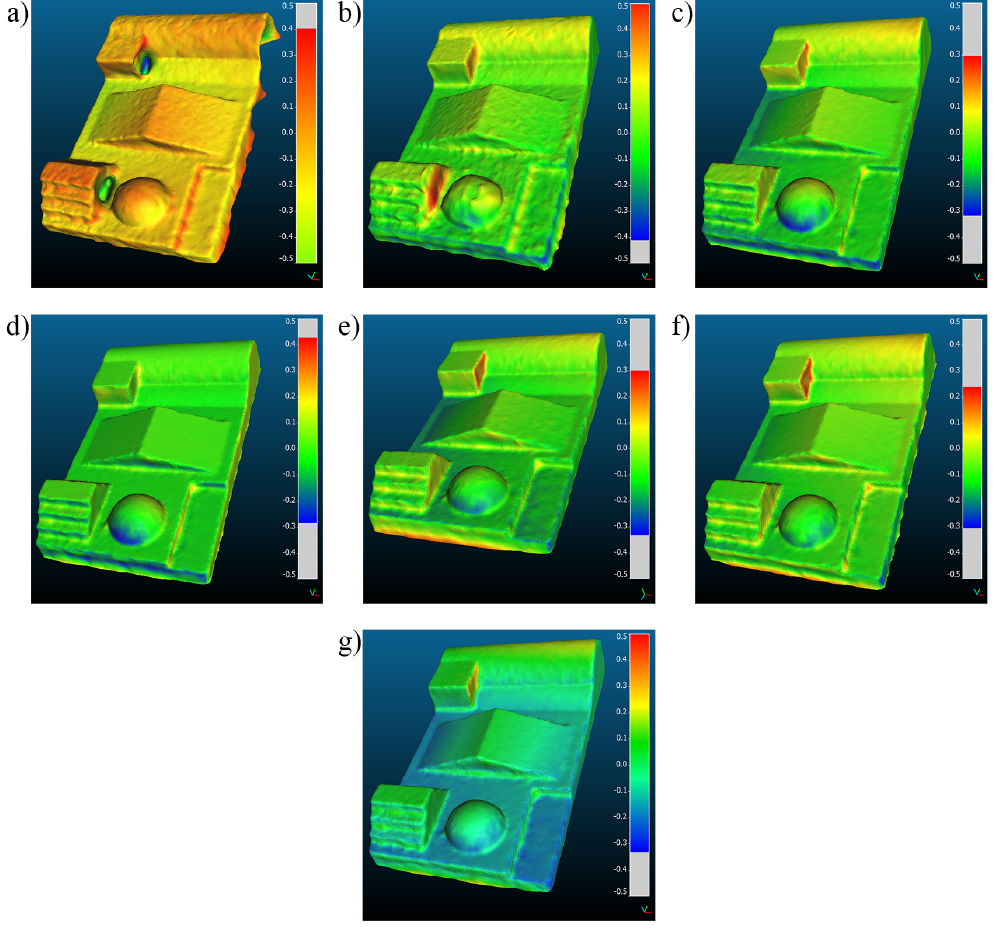
Figure 8. The heatmap representation of the test object for ( a ) HARRIS, ( b ) Shi-Tomasi, ( c ) MSER, ( d ) SIFT, ( e ) SURF, ( f ) KAZE, and ( g ) BRISK feature extraction methods. Grey color on the scle-bar represents values out of